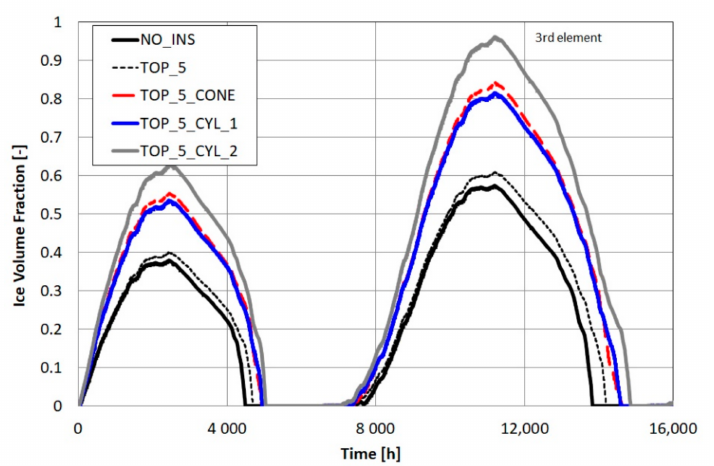
Figure 14. Ice volume fraction of the 3rd element of the IT.